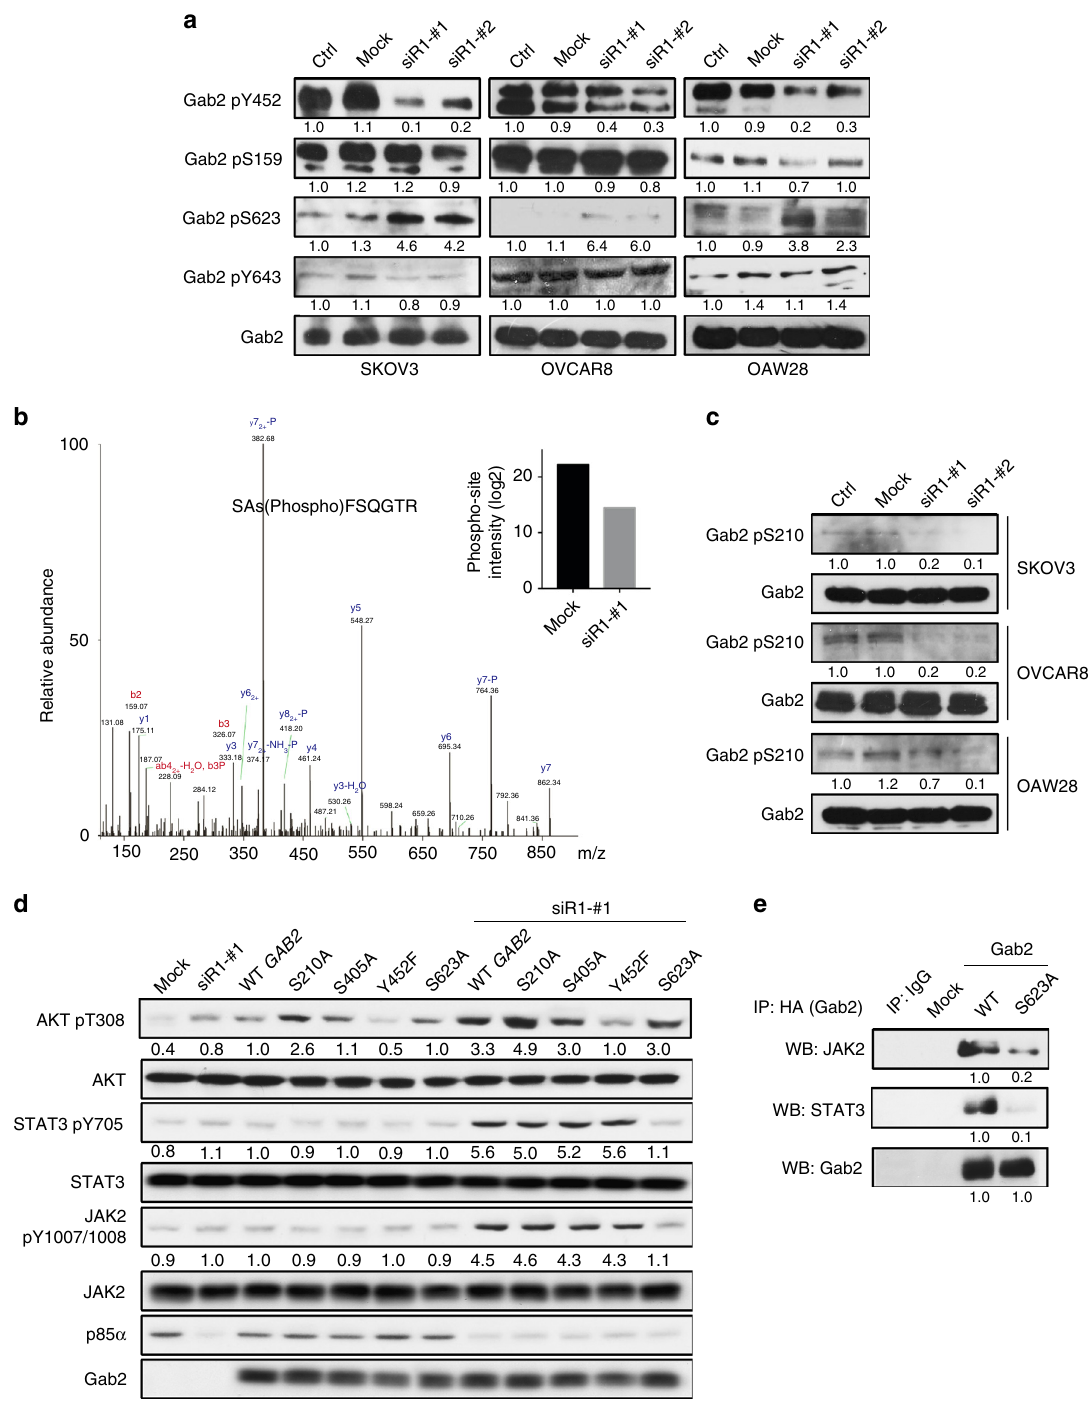
Fig. 4 PIK3R1 loss alters phosphorylation of Gab2 at S210 and S623, which in turn leads to signaling activation. a SKOV3, OVCAR8, and OAW28 cells were transfected with siRNA for 72 h prior to western blotting. b Protein lysates of HEK-293T transfected with PIK3R1 siRNA or non-speci fi c siRNA were subjected to immunoprecipitation with Gab2 antibody. The immunoprecipitates were subjected to SDS-PAGE separation for mass spectrometry-based quantitative phosphoproteomics. The MS/MS spectrum of phosphopeptide containing the S210 phosphorylated residue of Gab2 is shown. Inset, the log2 intensities of S210 phosphorylation in the samples. c SKOV3, OVCAR8, and OAW28 cells were transfected with siRNA for 72 h prior to western blotting. d OVCAR5 cells transfected with wild-type GAB2 or GAB2 mutants with or without PIK3R1 siRNA for 72 h were harvested for western blotting. e OVCAR5 cells transfected with HA-tagged wild-type GAB2 or GAB2 S623A mutant were subjected to immunoprecipitation with HA antibody and western blotting. Cells transfected with empty vector but not HA-tagged Gab2 was used as control (labeled as mock). The numbers below the blots represent the mean values from densitometry readings of three independent